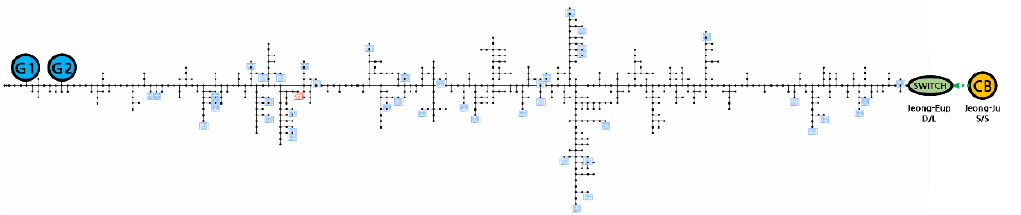
Figure 12. Single-line diagram of the Jeong-Eup D/L. G1 and G2 indicate the smart inverters while PV systems are represented by blue squares and the fossil plant is represented by a red square.